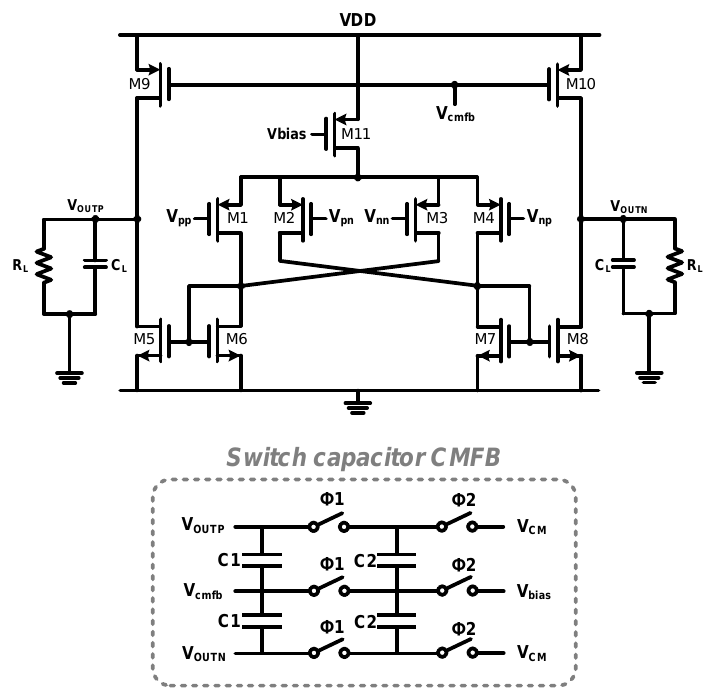
Figure 3. FDDA used in FD potentiostat.